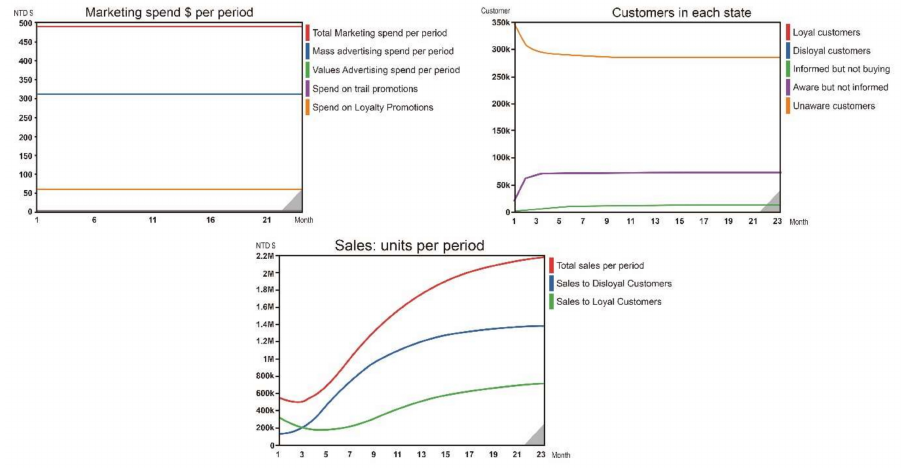
Figure 3. Simulated results of the original strategic business model and